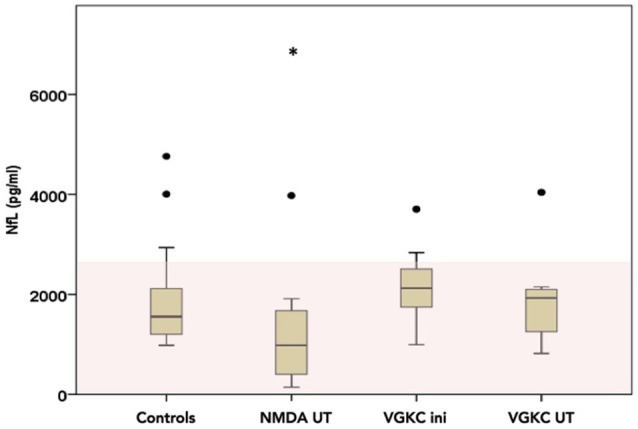
CSF-Neurofilament light chain (NfL) levels divided into three possible groups (NMDA under treatment n = 14, VGKC initial n = 7 and under treatment n = 6) as box plots (number of measurements, n = 30). The area in light red marks the normal range. Please note that all levels are inside the normal range. Line represents the median and the error bars represent the interquartile range. White points mean outlier and star extreme outliers.